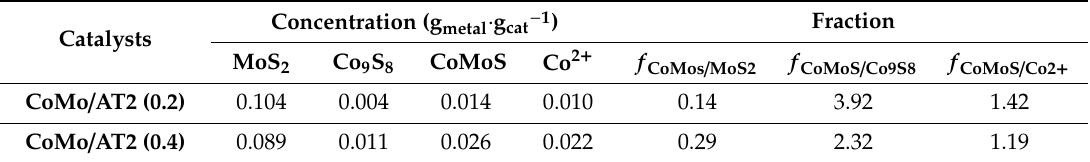
Table 6. Concentrations and atomic ratios of the Co and Mo species of the 15 wt.% Mo CoMo / AT2 catalyst at Co / (Co + Mo) = 0.2 and